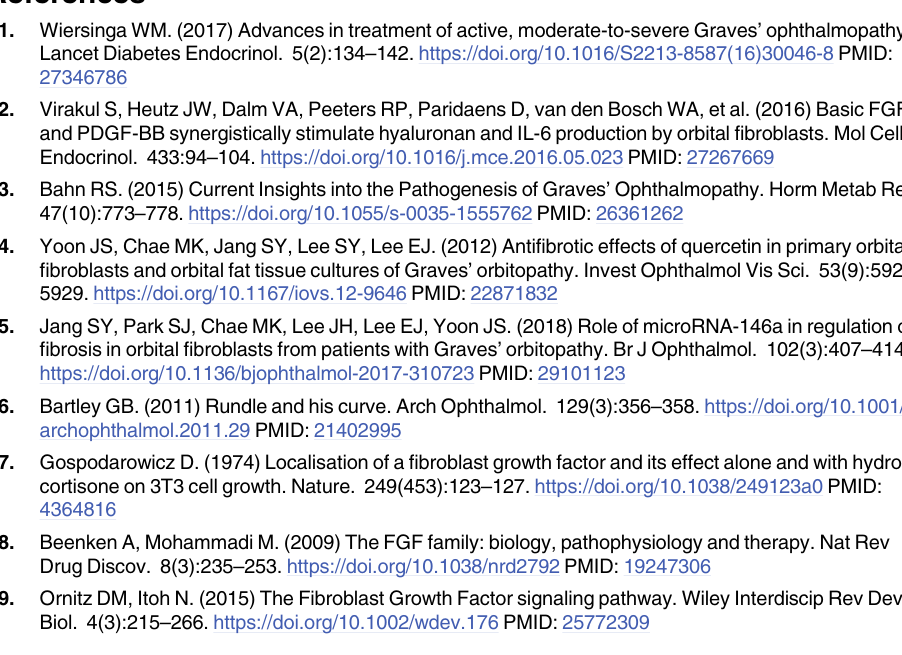
S1 Fig. Full length gels representative of Western blot analysis for Figs 1 and 2. S2 Fig. Full length gels representative of Western blot analysis for Fig 3. S3 Fig. Full length gels representative of Western blot analysis for Figs 4 and 5. S4 Fig. Full length gels representative of Western blot analysis for Figs 6 and